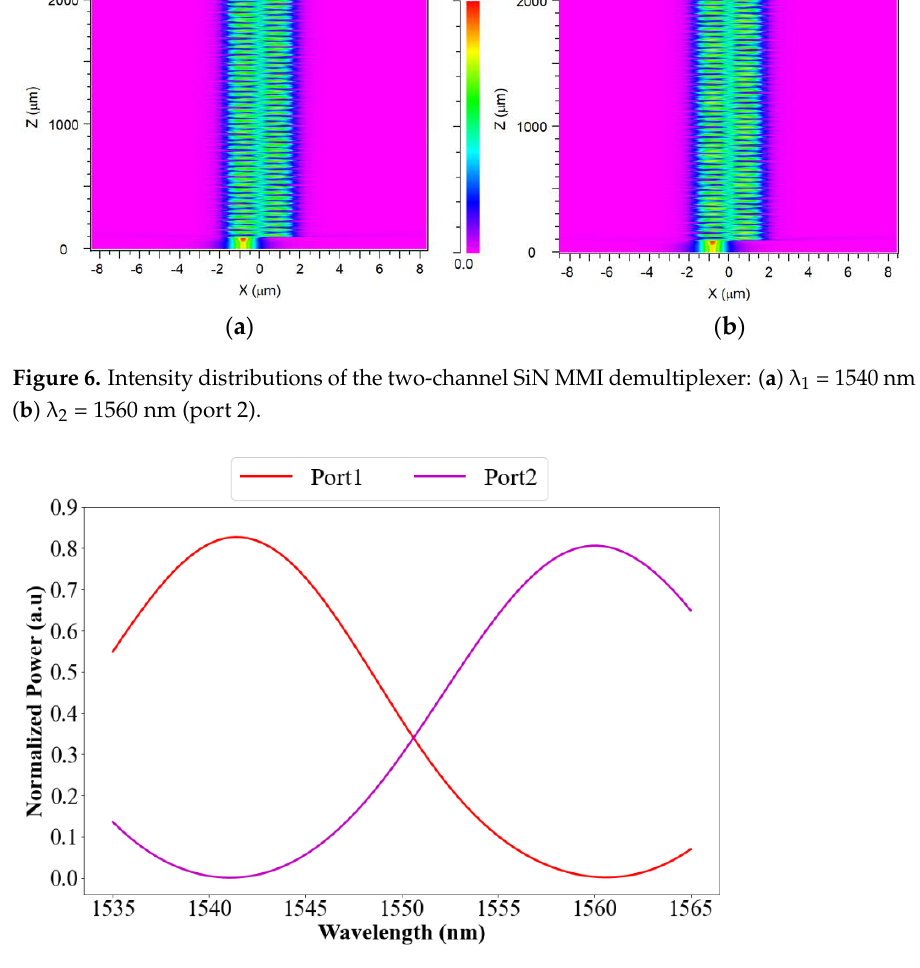
Figure 6. Intensity distributions of the two-channel SiN MMI demultiplexer: ( a ) λ 1 = 1540 nm (port 1); ( b ) λ 2 = 1560 nm (port 2).